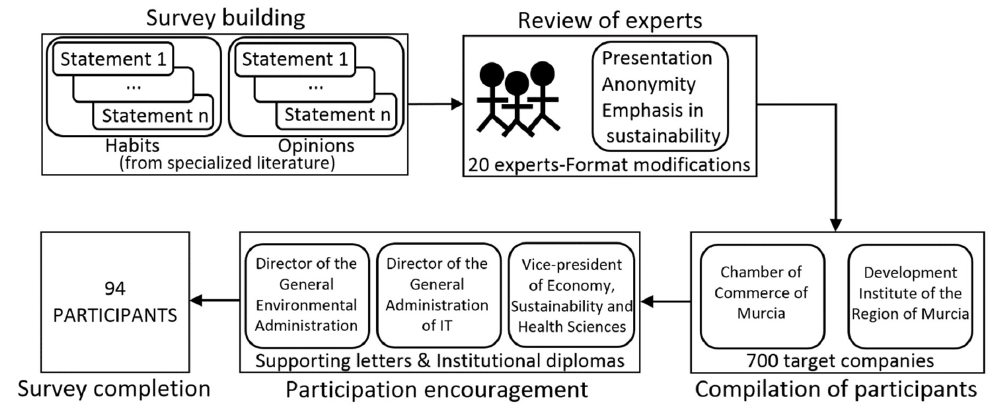
Figure 1. Research methodology.